Question: Write a single sentence explaining what this figure depicts.
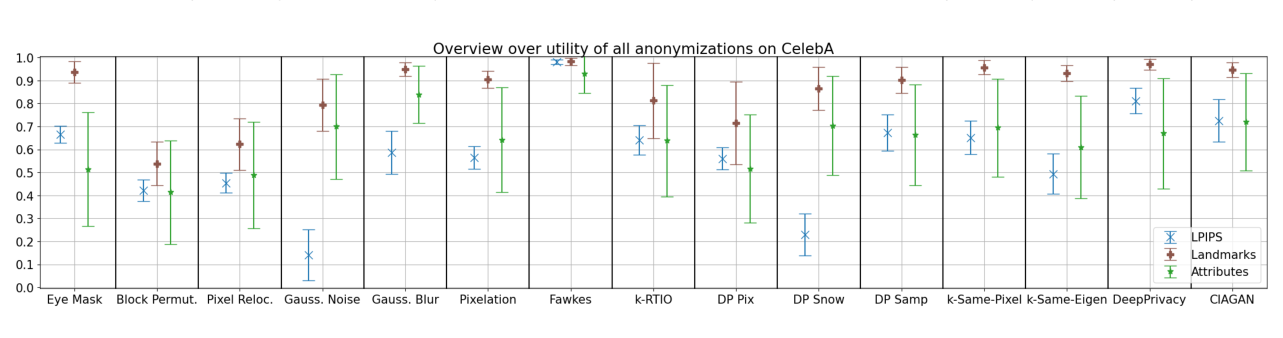
Answer: Mean utility and 95% confidence interval via perceptual similarity (LPIPS), attribute similarity, and landmark similarity for all anonymizations; on 300 identities of CelebA.